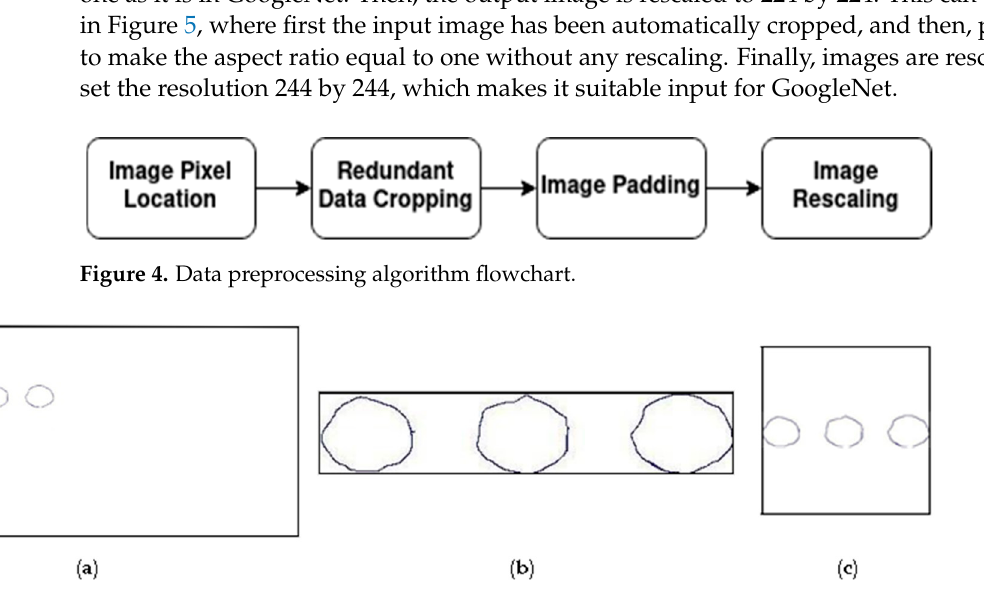
Figure 3. Example of all tasks for ASD and non-ASD subjects.